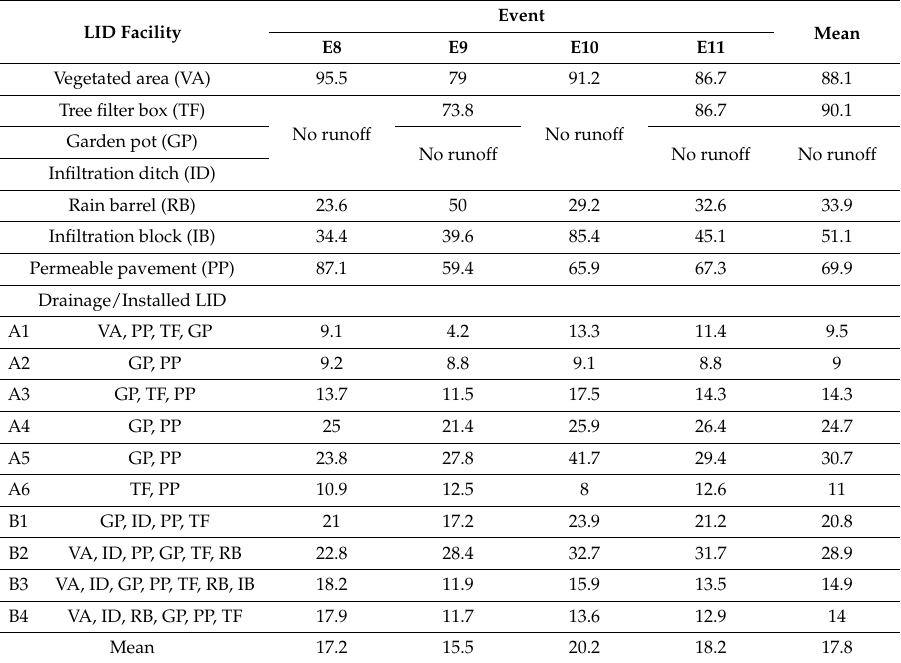
Table 4. Modeled runoff reduction (%) for four storm events.